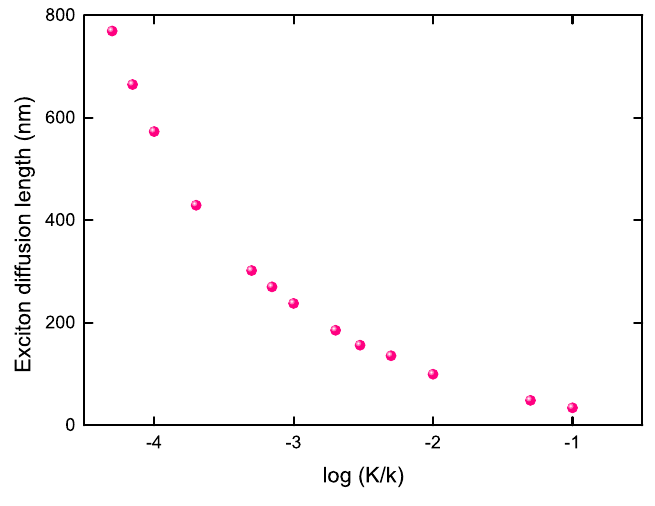
Figure 10. The influence of K / k ratio on the exciton diffusion length in 1D B850 nanoarray. The center of the laser profile is at x = 0 and the FWHM of the laser is 400